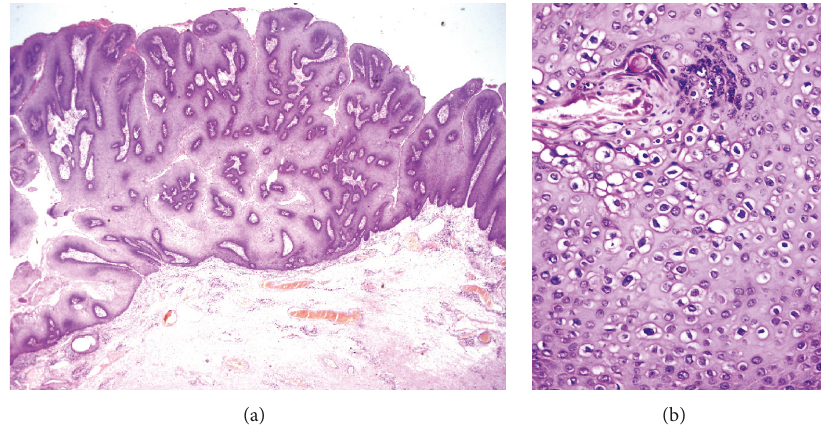
Figure 7: The histology of giant condyloma of Case 2. (a) x2 magnification (b) x40